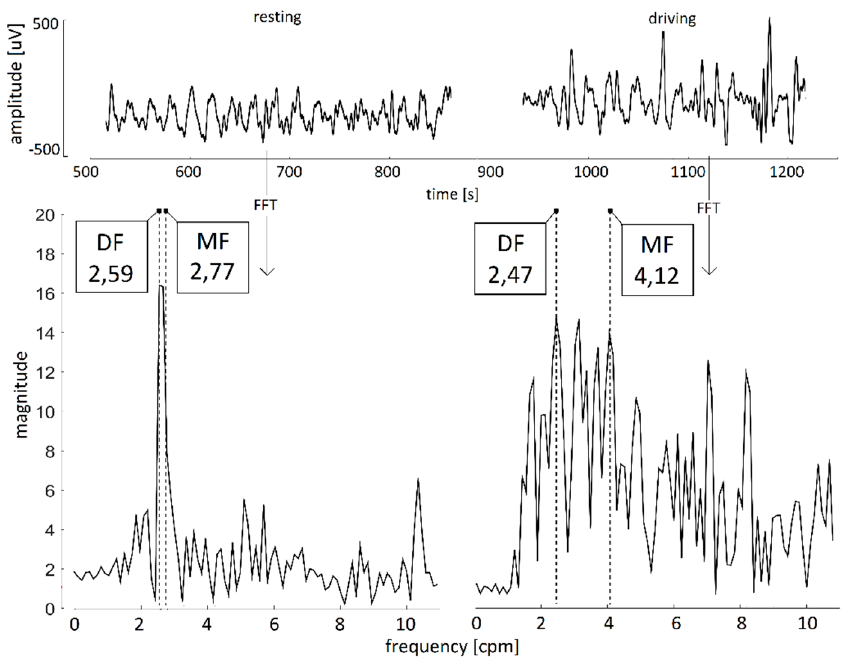
Figure 4. Illustration of difference between DF and MF parameters calculated from FFT of the EGG signal during resting and no-motion driving sequences.